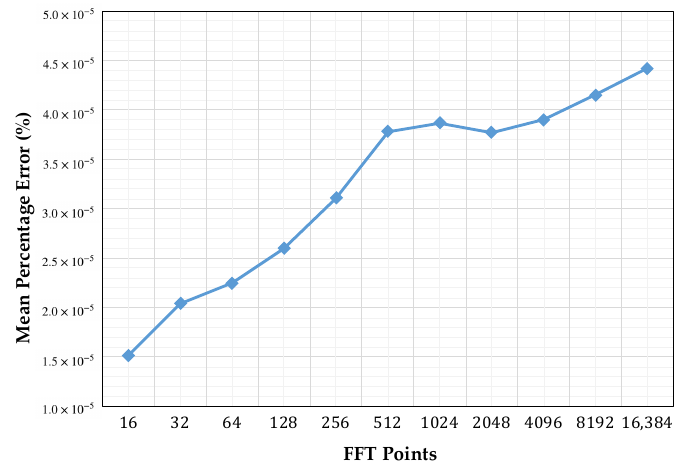
Figure 9. Mean percentage error of our core with respect to MATLAB R (cid:13) ’s FFT function.